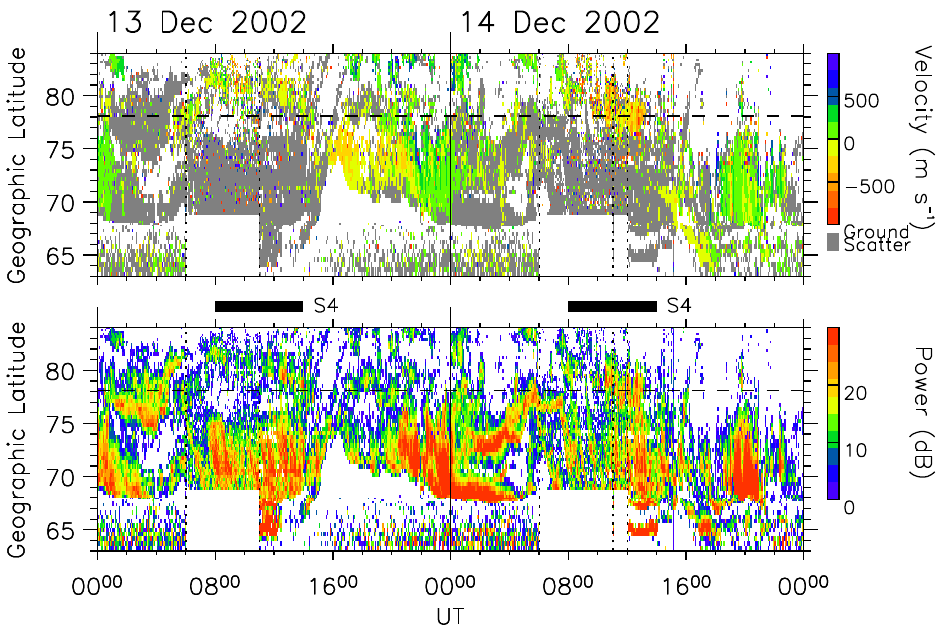
Fig. 1. Latitude-time velocity and power plots from beam 8 of the CUTLASS Finland radar on 13 and 14 December 2002. In the upper panel, backscatter identified as ground scatter is indicated in grey. Vertical dotted lines show times at which the radar changes scanning mode (see text for details). The horizontal dashed lines show the ionospheric intersection point of the satellite signals. The times that scintillation observations are available are shown by horizontal bars marked S4.